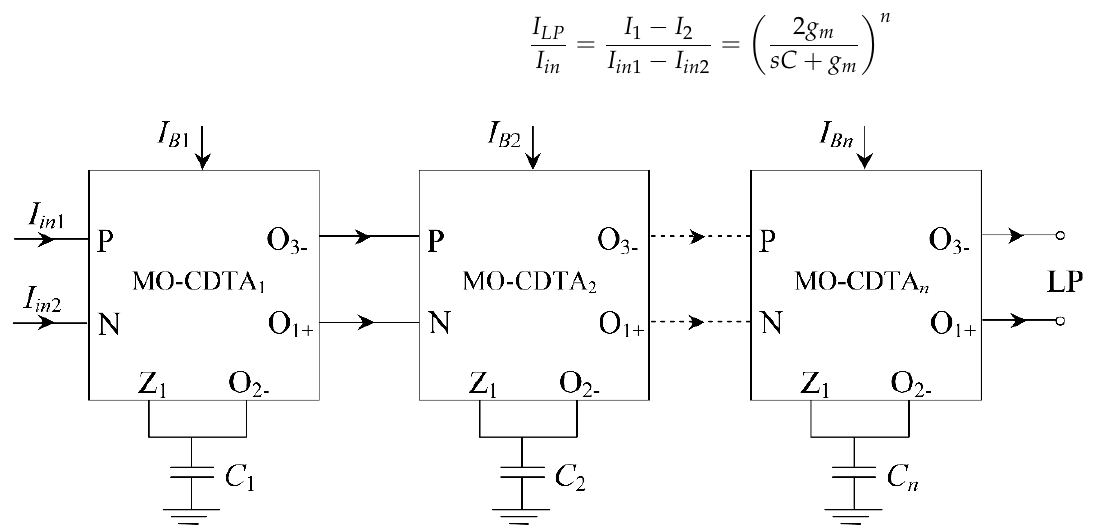
Figure 15. The proposed fully differential configuration realizing the n th-order LP filter.